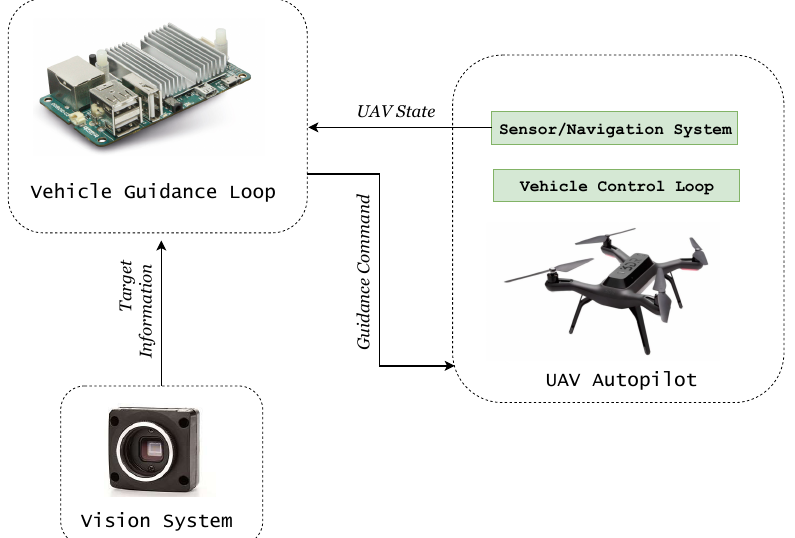
Figure 1. Block diagram of a vision-assisted guidance landing